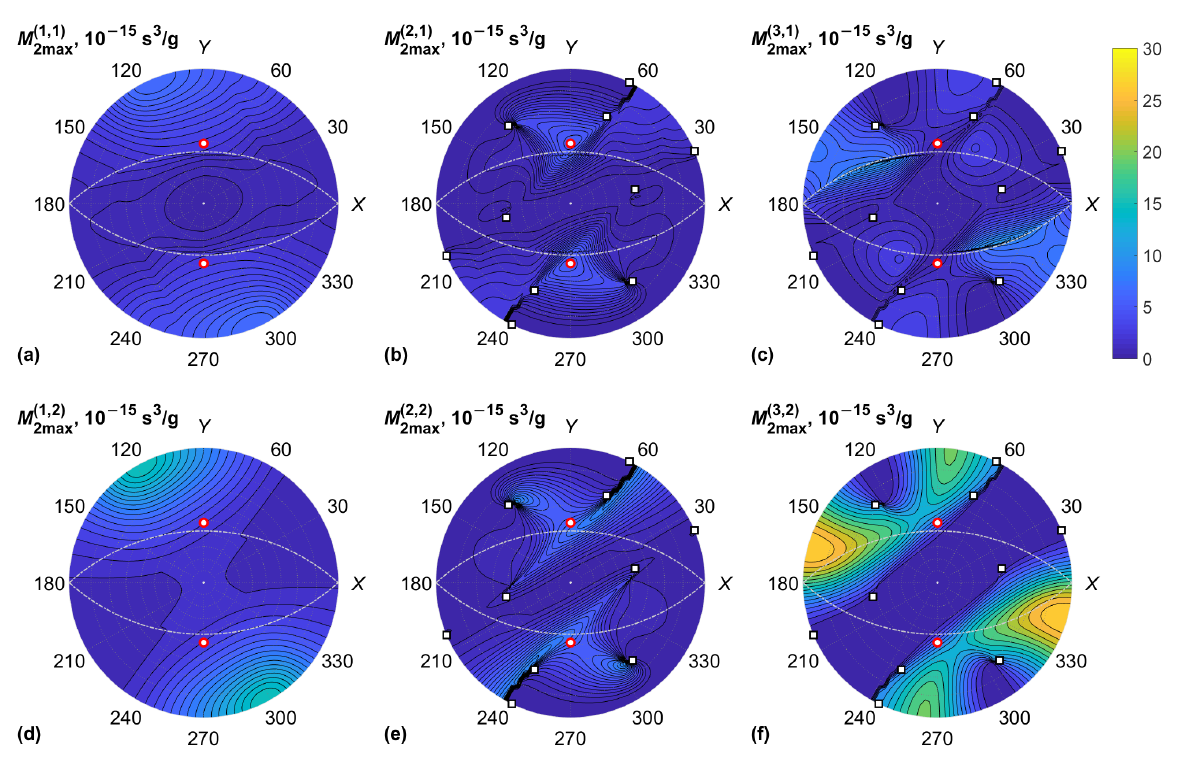
( α , β ) Figure 4. KGW crystal, maximum AO figure of merit, M vs. BAW direction ( ϕ , θ ) : ( a ) QL 2max BAW mode ( α = 1), fast optical mode ( β = 1); ( b ) fast QS BAW mode ( α = 2), fast optical mode ( β = 1); ( c ) slow QS BAW mode ( α = 3), fast optical mode ( β = 1); ( d ) QL BAW mode ( α = 1), slow optical mode ( β = 2); ( e ) fast QS BAW mode ( α = 2), slow optical mode ( β = 2); ( f ) slow QS BAW mode ( α = 3), slow optical mode ( β = 2). Conical acoustic axes of the crystal are marked with squares; optic axes are marked with red circles; directions orthogonal to optic axes are shown with dash-dotted